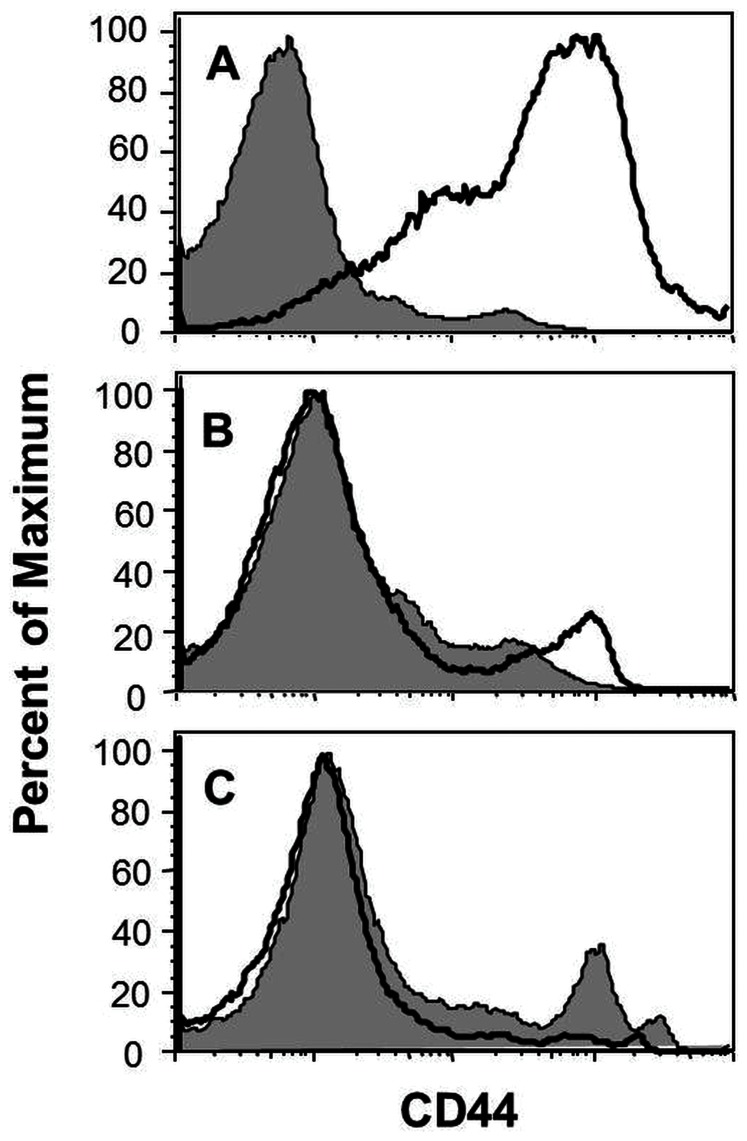
Hepatitis susceptible mouse strains display increased liver leukocyte CD44 expression in response to LD feeding.Hepatic leukocyte preparations were gated on forward and side-scatter and CD44 levels of B6 (A), BALB/c (B) and AKR (C) mice were examined by flow cytometry. Solid lines represent mice on LD and shaded lines represent mice on SD.